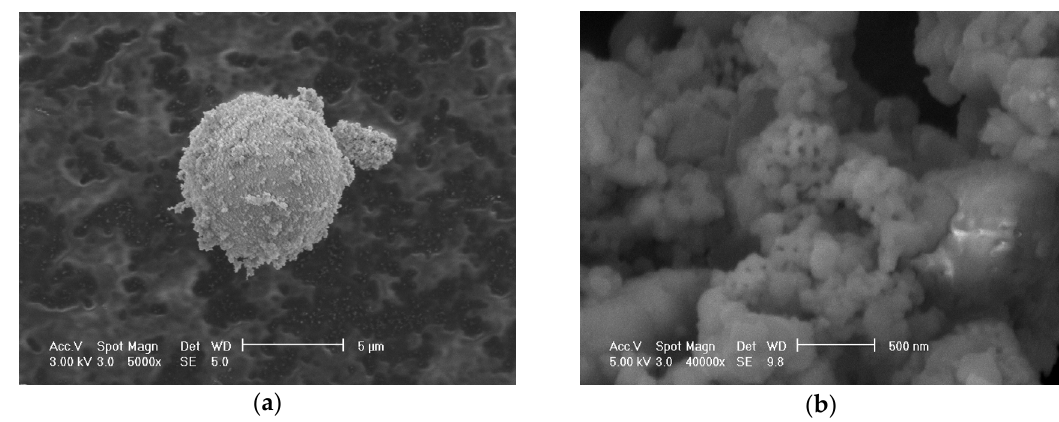
Figure 3. Compressive strength of pastes.